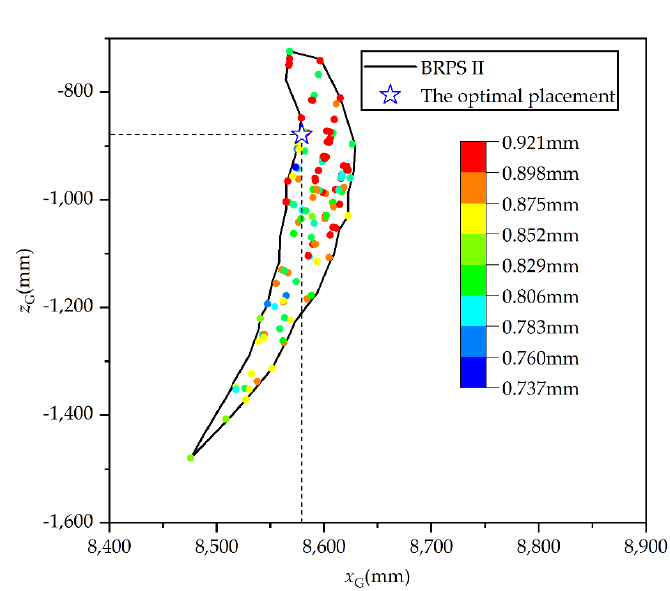
Figure 11. Distribution of static deformation of